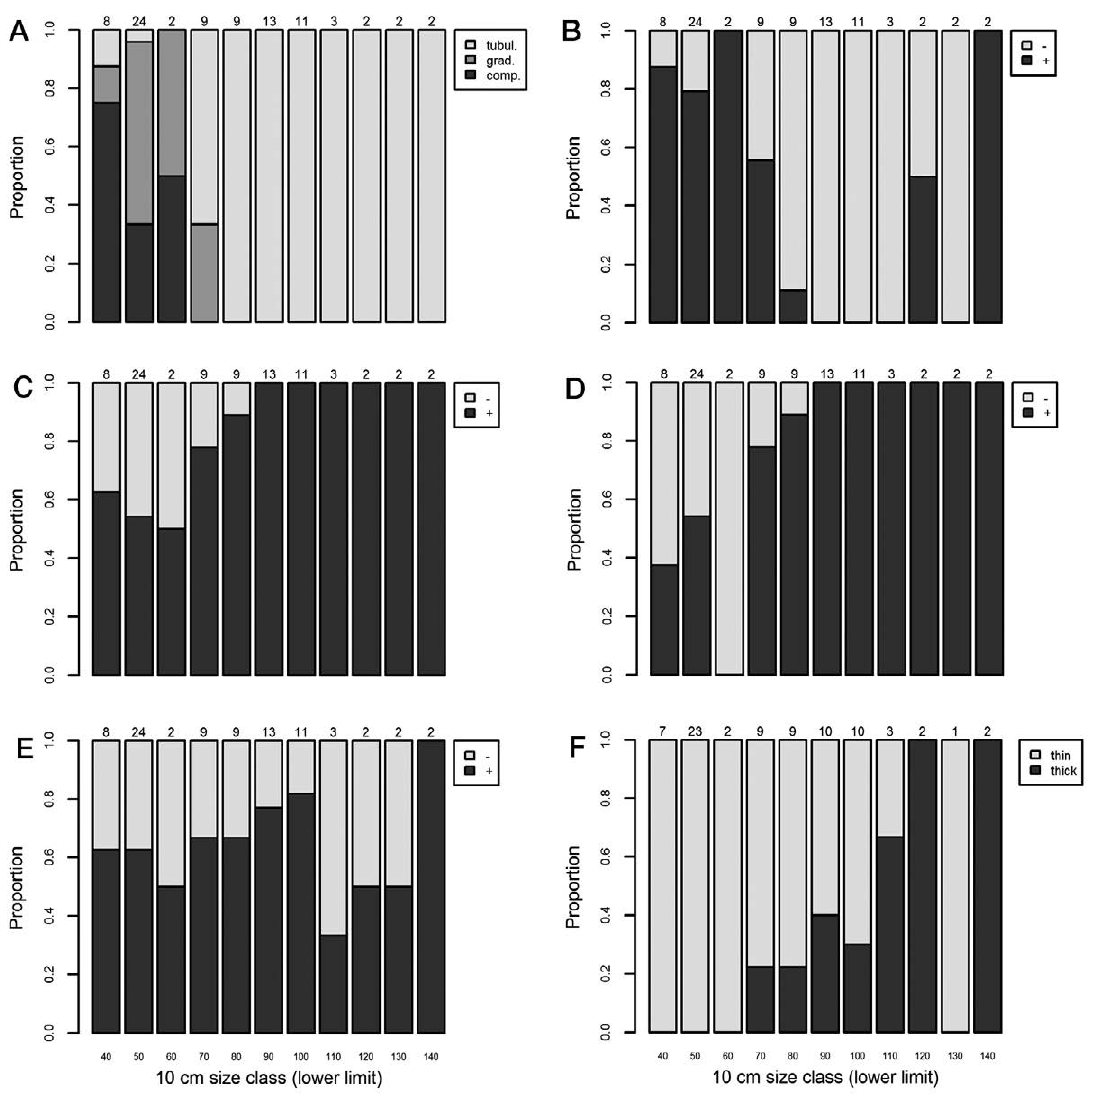
Fig. 7. – Size-related variations in the histologic characteristics of the testes of meagre during its putative spawning season (May and June). y -axis represents the proportion of samples that registered each feature. A, Overall testis structure (comp., compact; grad, gradient (compact at periphery, tubular at core); tubul, tubular); B, primary spermatogonia; C, primary spermatocytes; D, spermatids; E, spermatozoa; F, tunica thickness. “+”, abundant or very abundant; “-”, not abundant or absent. Numbers above bars are sample